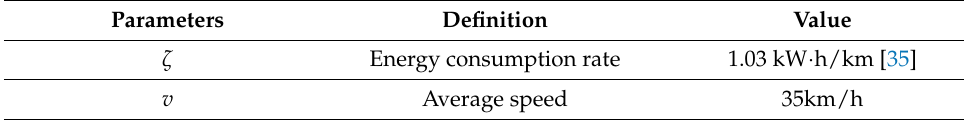
Table 10. Parameters of L-EVRPTW.